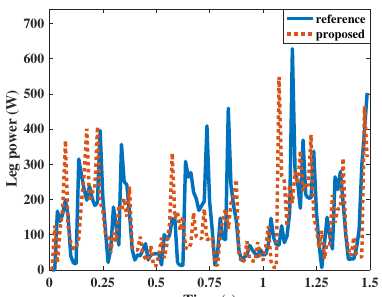
Figure 16. Leg powers of the RF leg in the SCalf prototype experiments.